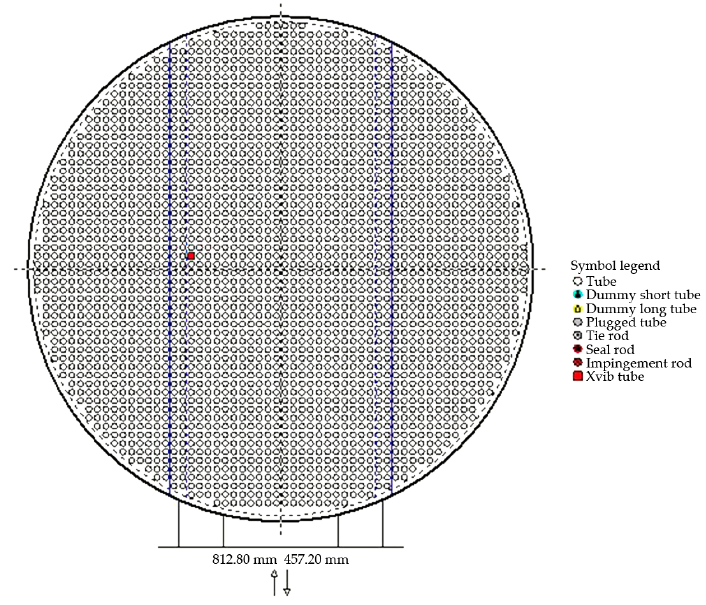
Figure 7. Selected tube for vibration analysis at baffle tip area.